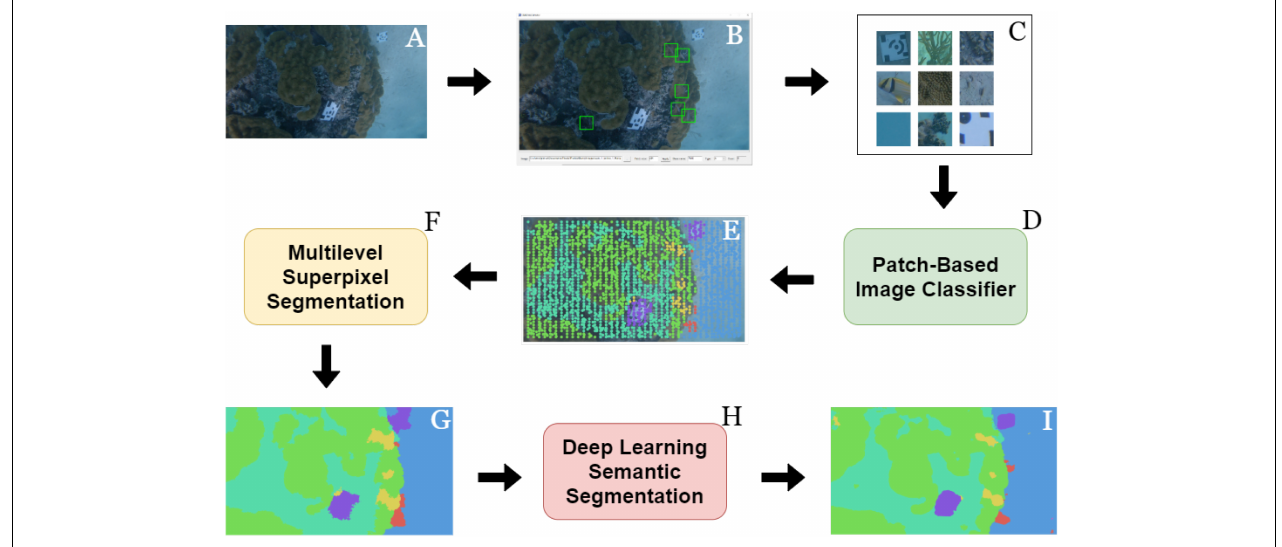
FIGURE 3 | A diagram illustrating the workflow used to obtain dense labels for each image. Still images were extracted from the video footage (A) and imported into Rzhanov’s patch-extraction tool (B) where patches for each class category of interest were extracted (C) . These patches and their corresponding labels were used to train a patch-based image classifier (D) that then provided numerous sparse labels to each image in the dataset (E) . Using Fast-MSS (F) , the sparse labels were converted into dense (G) and used as the pixel-wise labels necessary for training a deep learning semantic segmentation algorithm. (H) With a trained FCN, novel images collected from the same or similar habitats could then be provided with dense labels automatically (I) and without having to perform any of the previous steps (B–G)